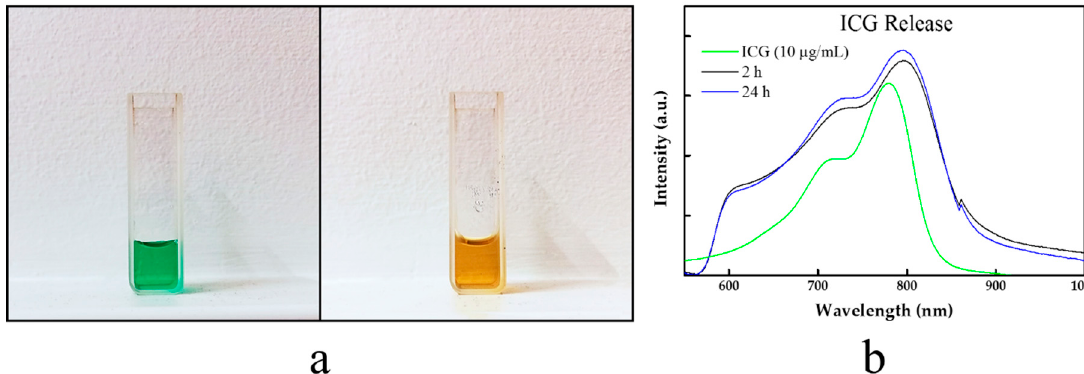
Figure 5. ( a ) The color change of ICG solution after NIR irradiation. Fresh ICG solution (left) and ICG solution after five irradiation cycles (right). ( b ) UV–Vis—NIR spectra of supernatant collected after 2